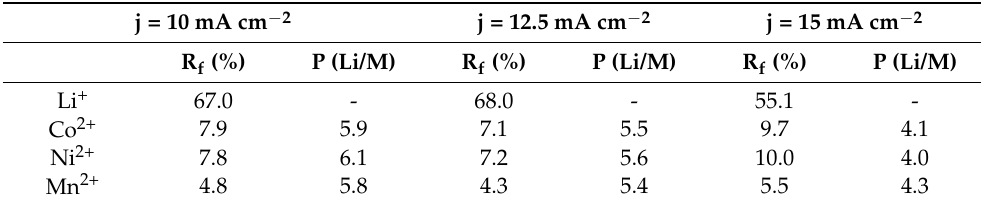
Table 2. Faradic efficiencies (R f ) for the transfer of lithium(I), cobalt(II), nickel(II) and manganese(II), and permselectivity indexes P(Li/M) at current density j = 10 mA cm − 2 , 12.5 mA cm − 2 et 15 mA cm − 2 after performing electrodialysis during 240 min (Flowrate =100 mL min − 1 in all compartments, Neosepta ® monovalent-selective cationic exchange